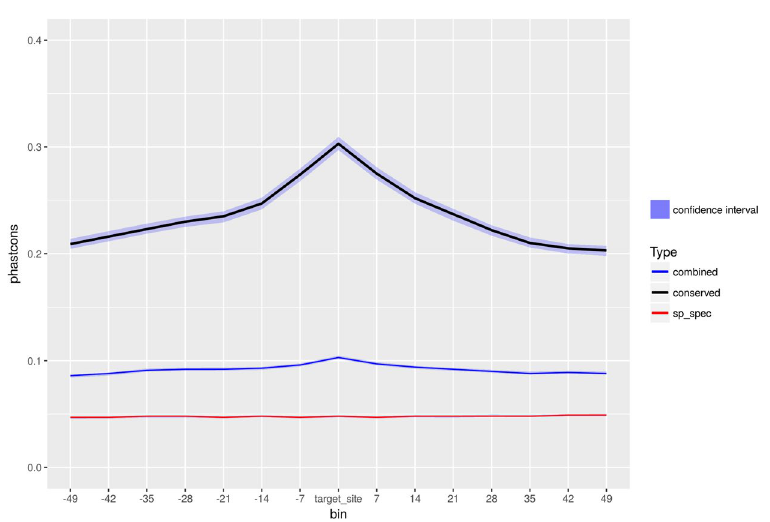
Figure 7. Median and confidence interval of 20-way Phastcons scores, calculated across 7nt bins, centred around the predicted targets of conserved (black line), species specific (red) and combined (blue) seed families.